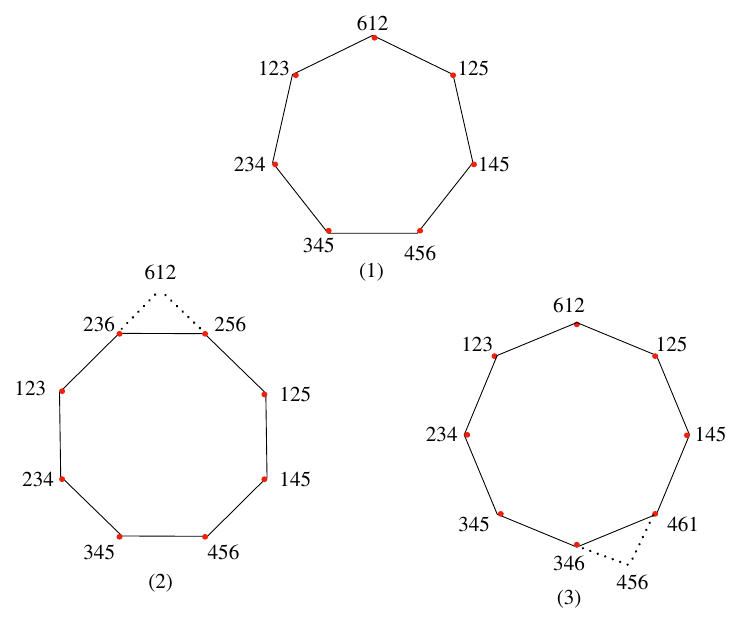
Figure 2 . Polygons for each six-point cell in A 234